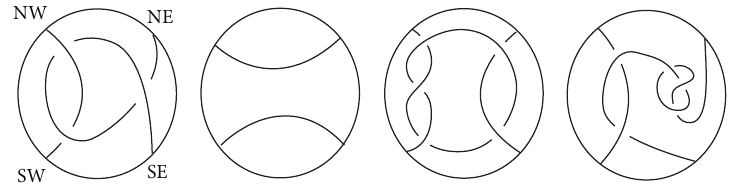
Figure 1: Rational, trivial, prime, locally knotted